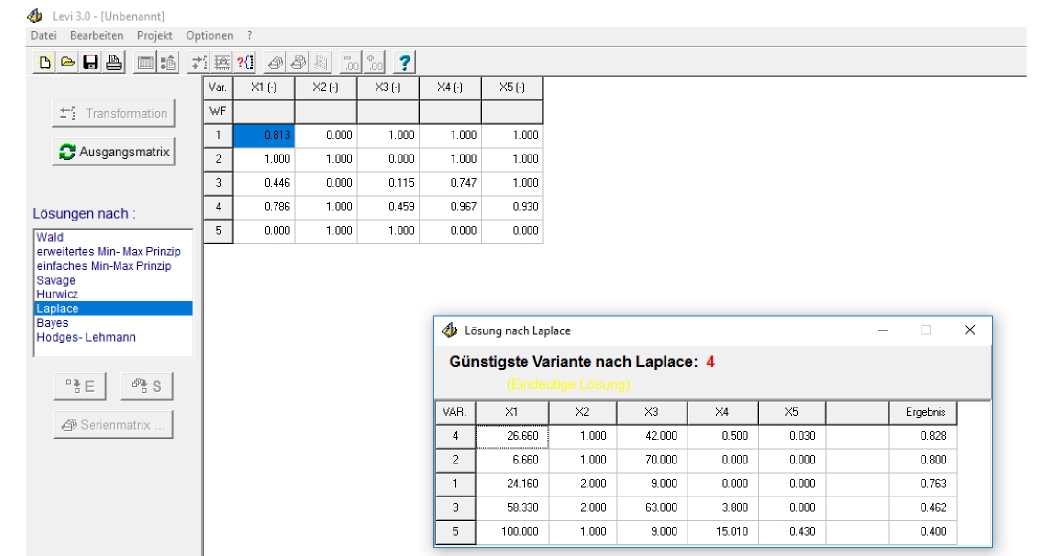
Figure 5. Normalised